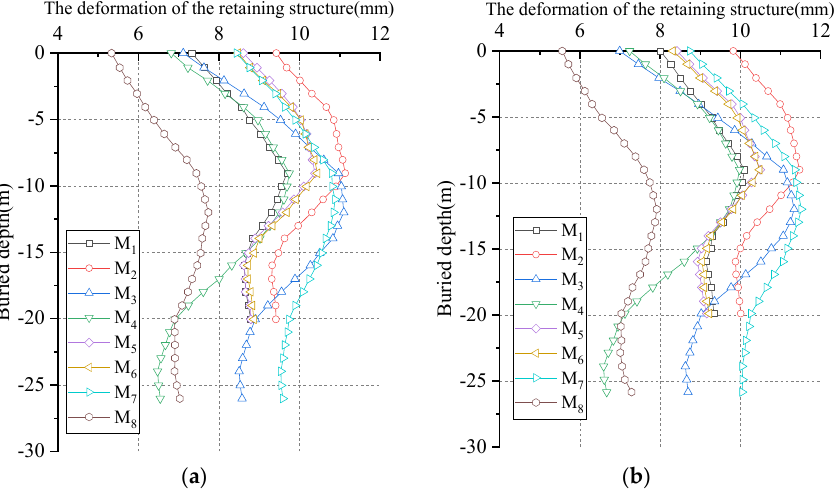
Figure 17. Deformation of the exterior retaining structure. ( a ) working Condition 4. ( b ) working Condition 5.